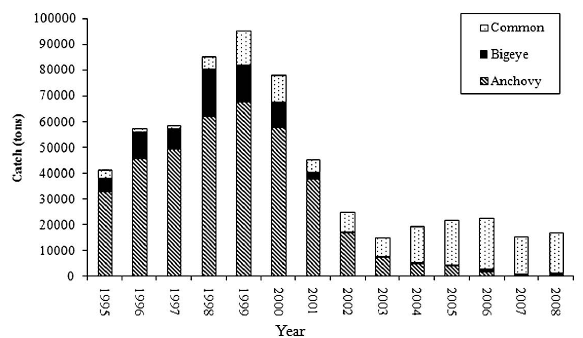
Fig . 6. – Contribution of different kilka species to the total kilka catch from the south Caspian Sea in 1995-2008 (according to Ira- nian Fisheries Organization data,